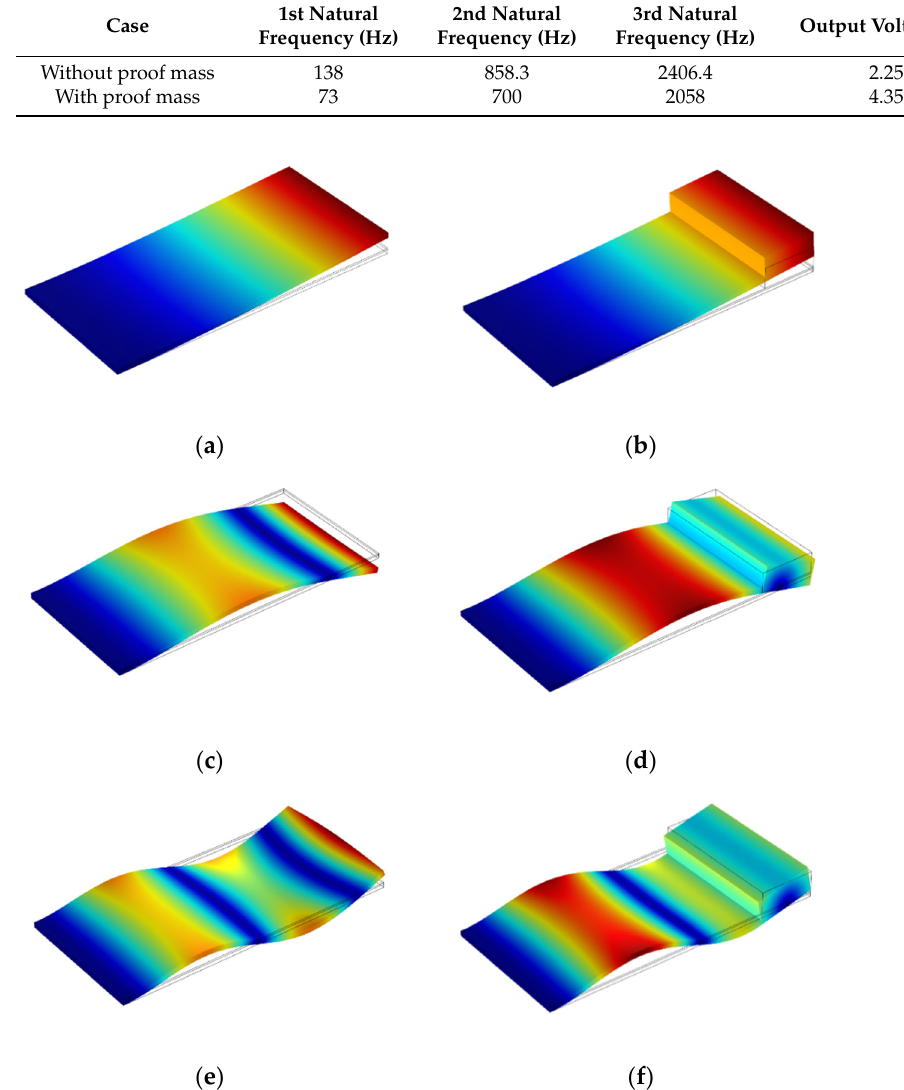
Figure 11. The mode shapes of the rectangular beam with and without a proof mass: ( a , b ) first mode shape, ( c , d ) second mode shape, and ( e , f ) third mode shape.